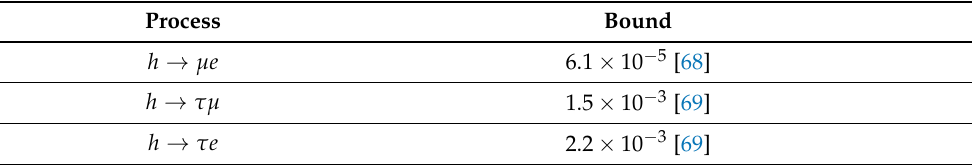
Table 1. Lepton flavor violating decay of the SM Higgs boson with the current experimental bounds set by ATLAS and